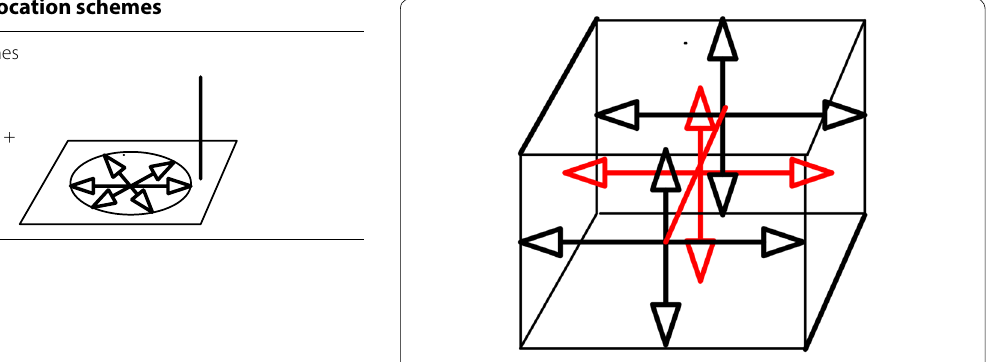
Figure 17 F&C line graph of mobile platform